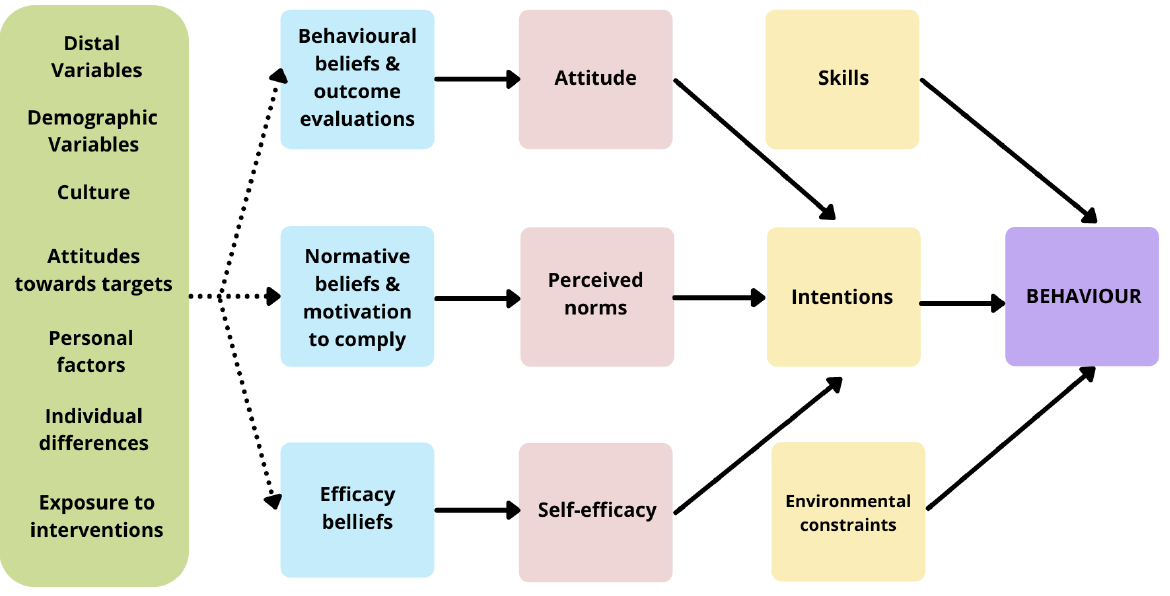
Figure 1. Integrated Model of Behaviour Change (IMBC), adapted from Brennan et al., 2020 [14]. Reproduced with per- mission.